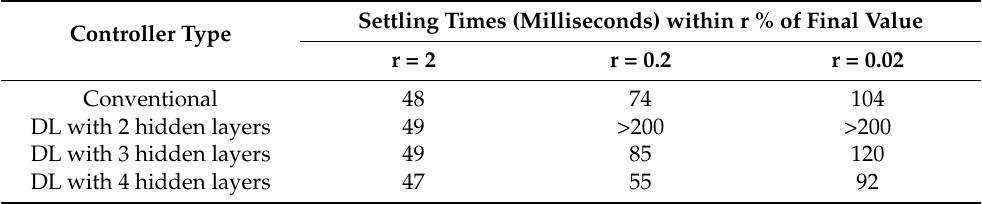
Table 1. Unit step response settling times for the different types of controllers under